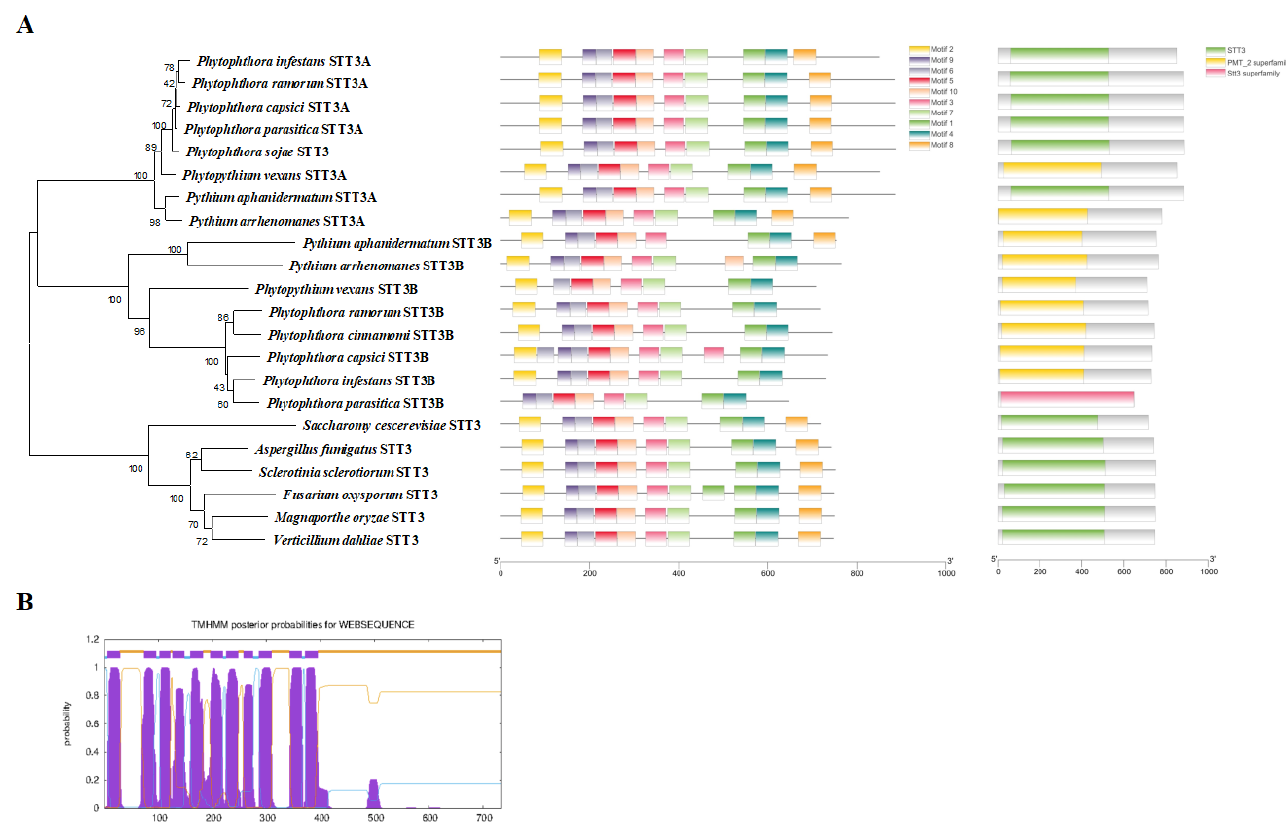
Figure 2. Sequence analyses of PcSTT3B protein. ( A ) Neighbor-joining phylogenic tree based on STT3 proteins of oomycetes and fungi. Bootstrap percentages indicate the occurrence probabilities of 1000 replicates. The scale bar represents 20% weighted sequence divergence as the scale of the evolutionary tree. The branch length reflects the evolutionary distances among STT3 proteins. Motifs and domains of STT3 proteins are in the oomycetes and fungi. ( B ) Transmembrane domain analysis of PcSTT3B using